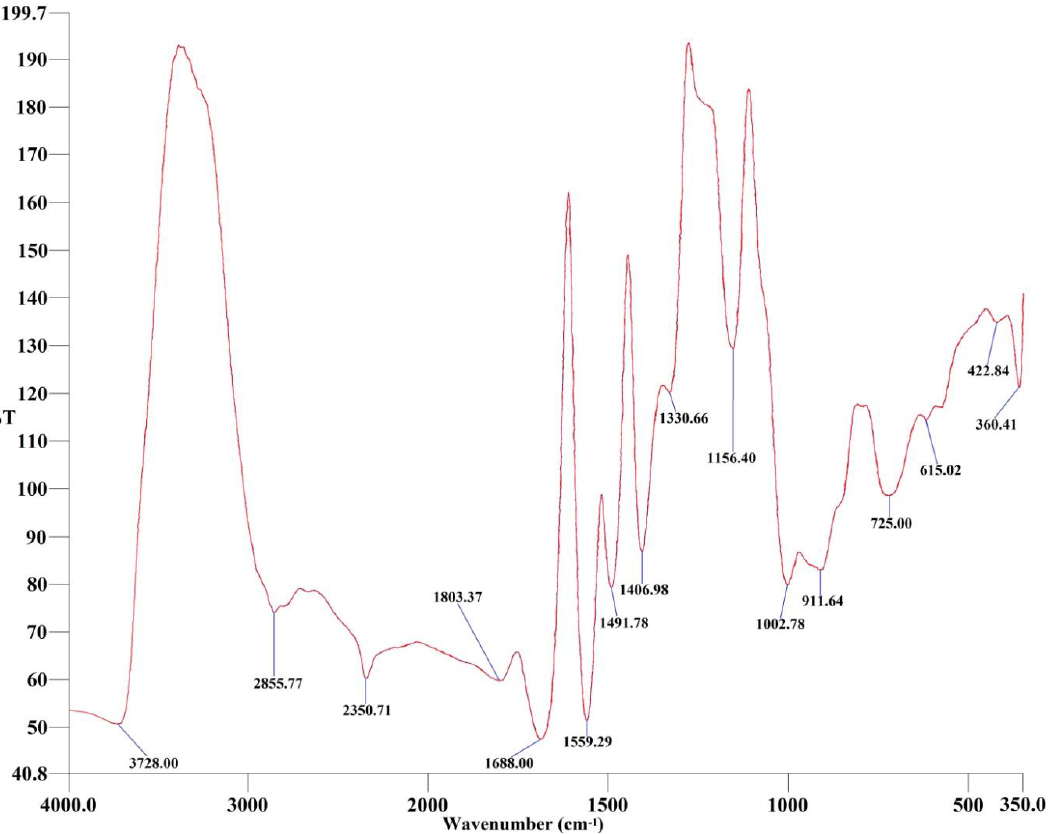
Figure 6. Fourier Transform Infrared (FT-IR) spectrum of P. muellerianus leaf-extract.